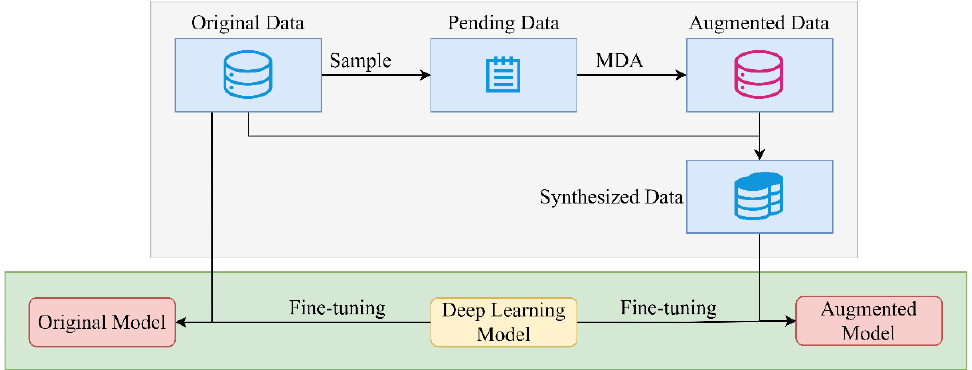
Figure 2. The prototype of the data augmentation process.